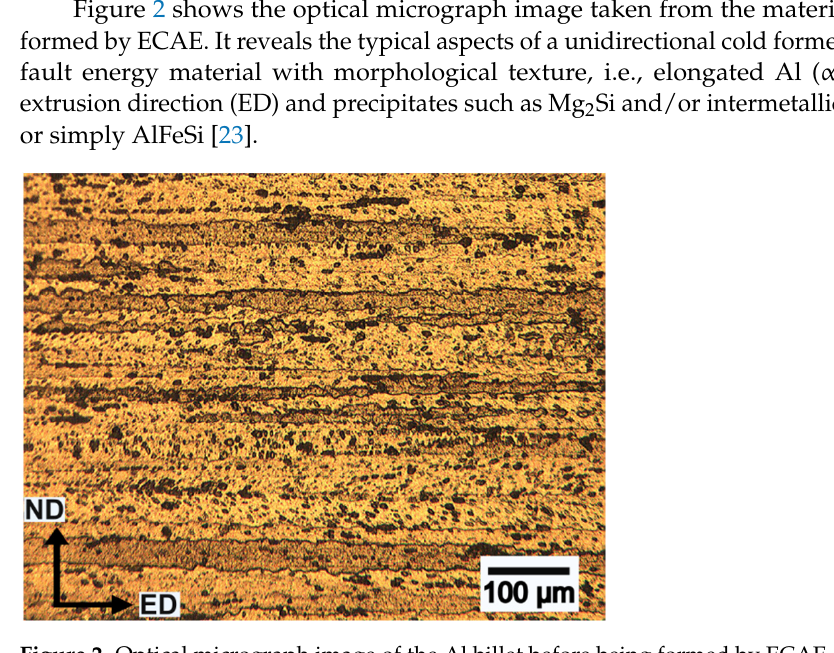
Figure 2. Optical micrograph image of the Al billet before being formed by ECAE (×100). Tensile tests of the material before the ECAE were carried out according to [24] on an INSTRON universal testing machine (INSTRON, Massachusetts, USA). The true stress- strain curve of the material obtained during tests is shown in Figure 3. The elastic region was identified and characterized. The region with a uniform plastic strain was interpolated by means of a Hollomon type law [25]. A summary of the values of the Young modulus (E), Poisson ratio ( ν ), yield strength ( σ 0.2 ), coefficient of resistance (K), and strain hardening exponent (n) of the Hollomon equation obtained and used in the simulations to be presented below are listed in Table